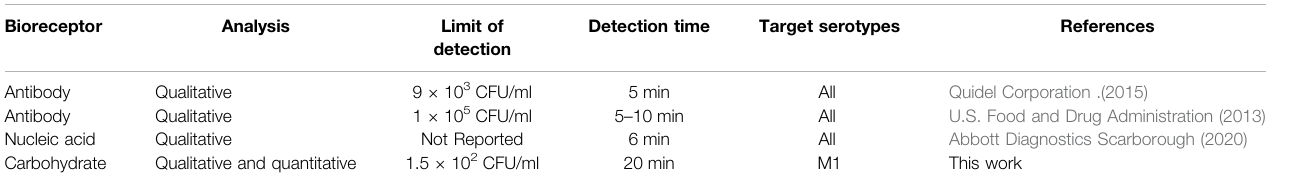
TABLE 1 | Comparison of H-1-AuNPs with previously reported biosensors for detection of GAS. Bioreceptor